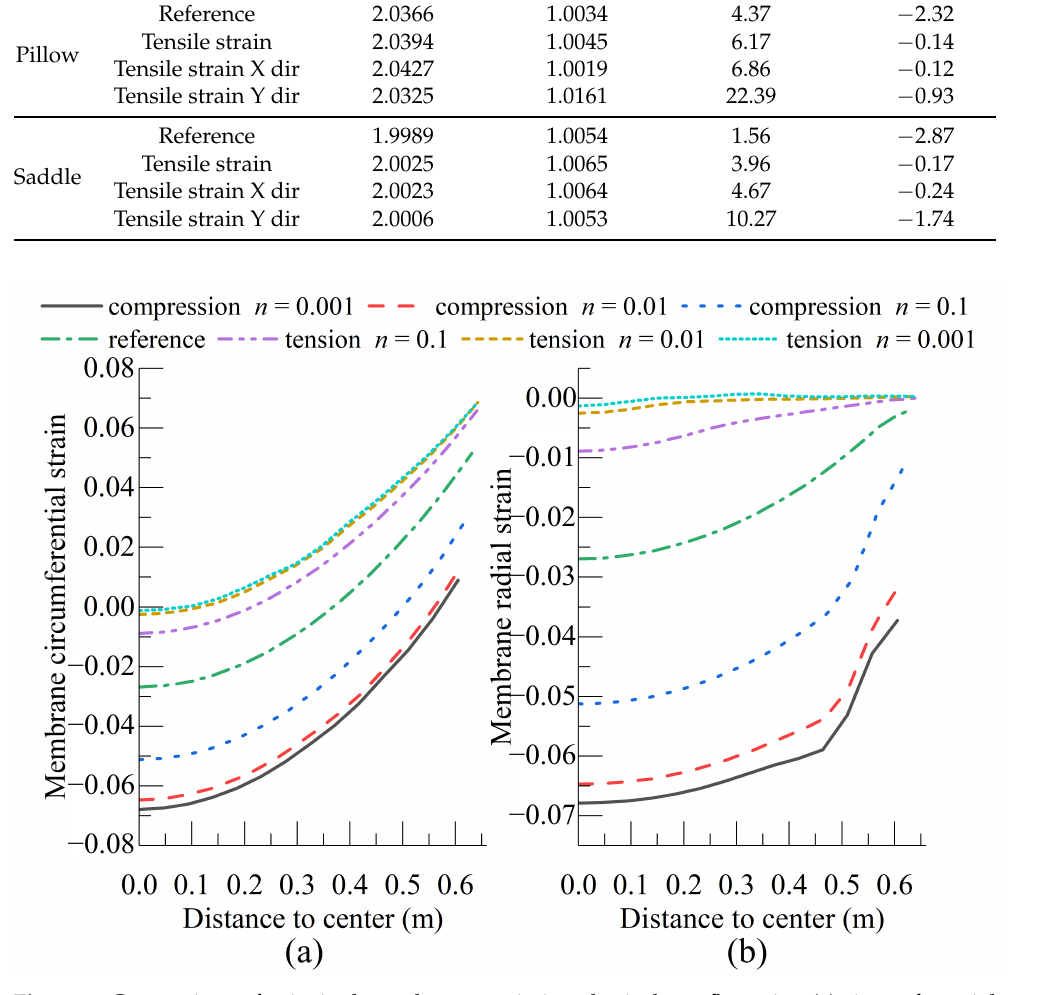
Figure 8. Comparison of principal membrane strain in spherical cap-flattening ( a ) circumferential strain, ( b ) radial